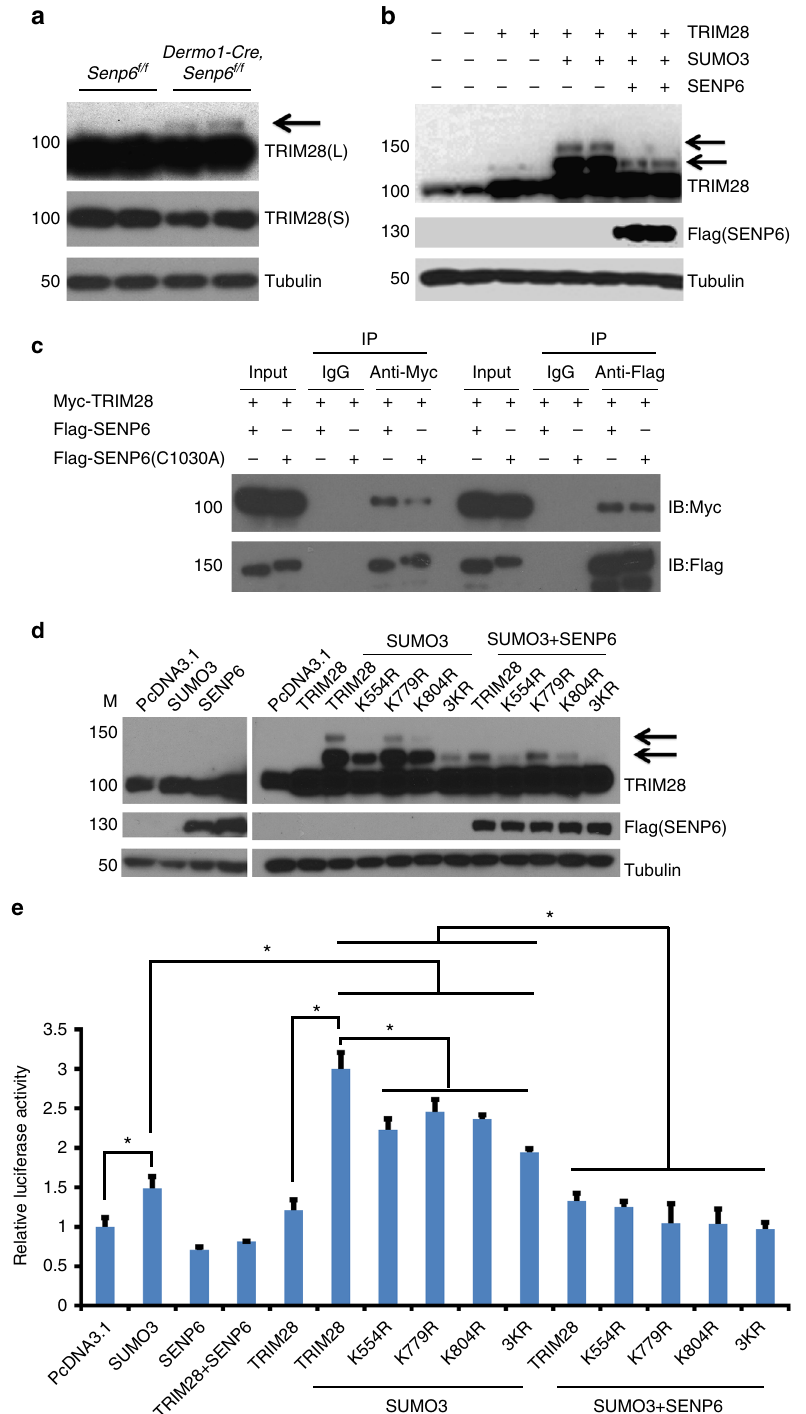
Fig. 5 SENP6 desumoylated and stabilized TRIM28 and suppressed p53. a Senp6 loss decreased the total TRIM28 protein in E18.5 Dermo1-Cre;Senp6 f/f rib cartilage but increased sumoylated TRIM28 (upper bands denoted by the arrow). “ L ” or “ S ” indicates long or short exposure ( n = 3). b SUMO3 modi fi cations on TRIM28 can be removed by overexpressed SENP6 ( n = 2). c TRIM28 can be immunoprecipitated with either wild-type SENP6 or enzymatic-activity-null SENP6 (C1030A). d , e . Sumoylation-resistant TRIM28 mutations impaired TRIM28 sumoylation and p53 activation. Western blots showed that the K554R, K804R, K779R, and 3KR mutations of TRIM28 reduced TRIM28 SUMO3 modi fi cations, and SENP6 effectively removed SUMO3 modi fi cation from all these sites ( d ). p53 reporter luciferase assays showed that the sumoylated TRIM28 enhanced p53 signaling, which was abolished by the addition of SENP6; these TRIM28 mutants induced signi fi cantly lower p53 activity than WT TRIM28 did ( n = 3; error bars = standard deviation, * p < 0.05, Student ’ s t -test) ( e